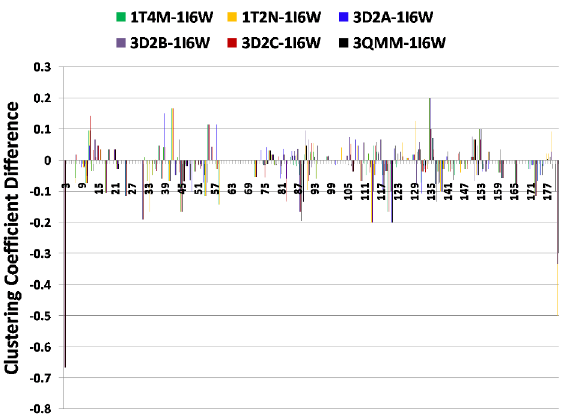
Figure 6. Number of contacts made and lost in the mutants. Contacts made (Blue) and lost (Green) in all the mutants as compared to the WT. Red bars show the number of contacts made with loops and purple bars show the number of contacts lost in loops. Cyan bars show the number of long range contacts made in mutants.